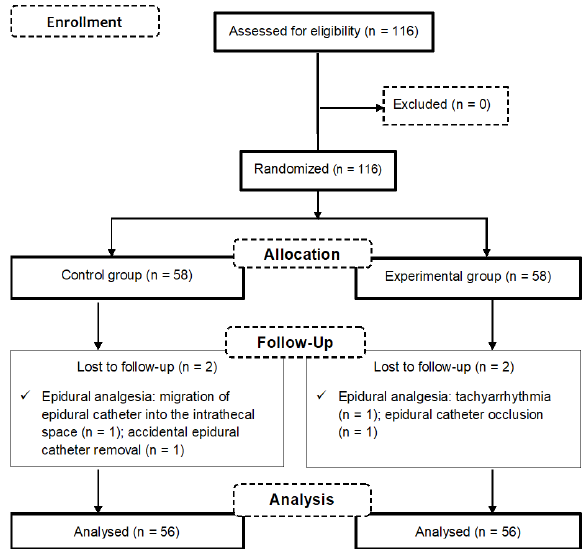
Fig. 1. CONSORT Flow Diagram of patients’